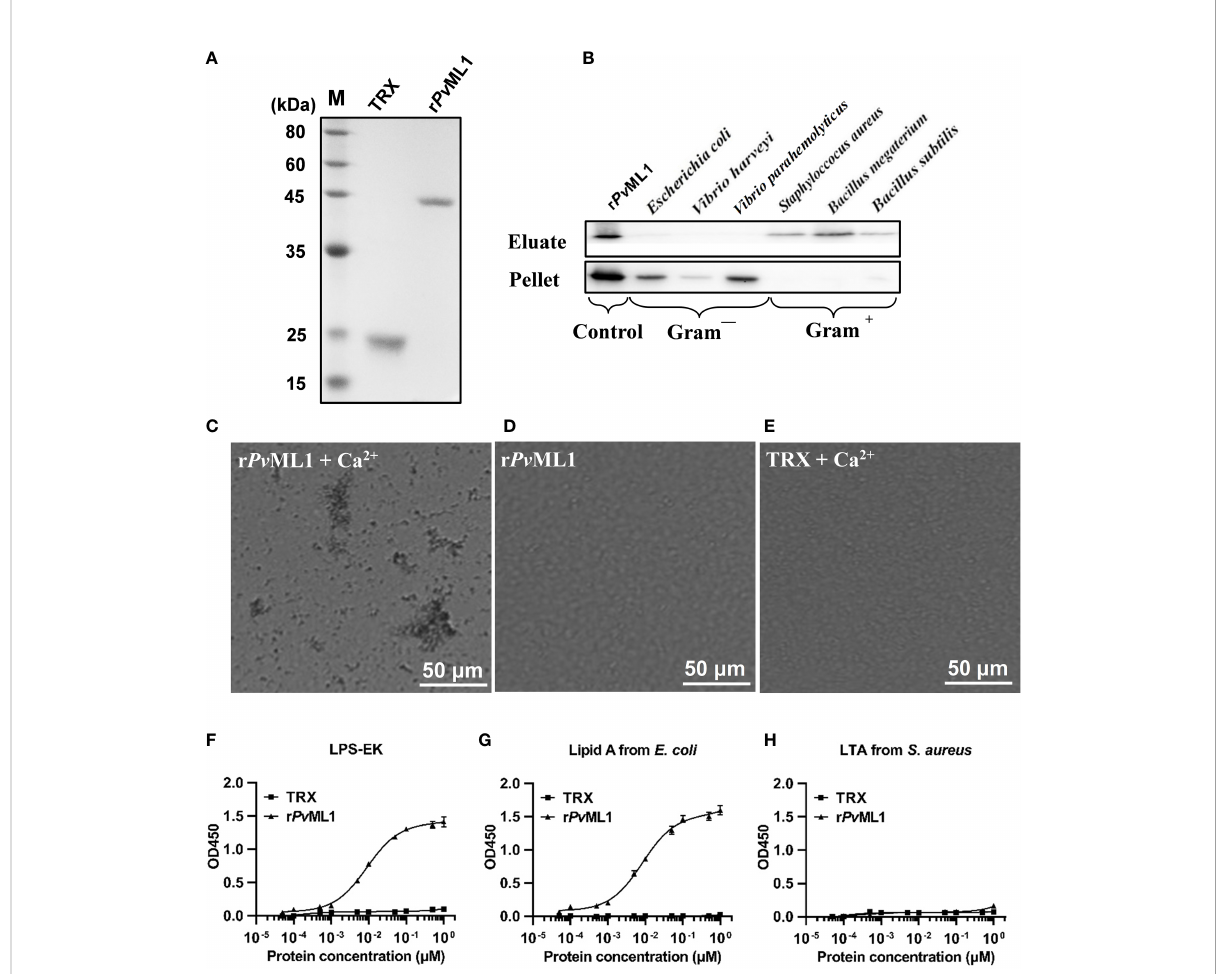
FIGURE 3 Pv ML1 possessed a strong binding and agglutination activity to Vibrio cells by binding to Lipid A of LPS. (A) Recombinant Pv ML1 (r Pv ML1) and TRX were expressed in E. coli and then puri fi ed. Lane M, protein marker; Lane TRX, the puri fi ed tag protein TRX; Lane r Pv ML1, the puri fi ed recombinant protein Pv ML1. (B) Binding activity of Pv ML1 to different microorganisms. The binding activities of Pv ML1 were con fi rmed by Western blot. Eluate panel, elution fractions; Pellet panel, fi nal pellet fractions. r Pv ML1 were sampled as the positive controls. Agglutination of V. parahemolyticus induced by Pv ML1. V. parahemolyticus was incubated with r Pv ML1 with (C) or without Ca 2+ (D) . TRX was used as the negative control (E) . Agglutination was observed under light microscopy. Microbial polysaccharide-binding activities were investigated using ELISA. LPS- EK (F) and Lipid A from E. coli (G) , and LTA from S. aureus (H) were used to coat plates. r Pv ML1 and TRX (negative control) were serially diluted and then added to the polysaccharide-coated plates. Results were obtained from three independent experiments.